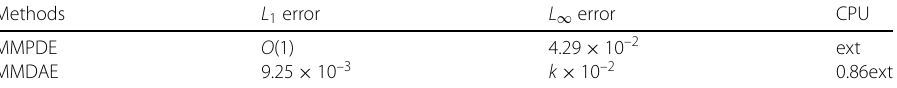
Table 1 Computation of L 1 and L ∞ errors using MMPDE and MMDAE methods with ρ = 10 4 , α = 1.5, β = 0.1, a = 1.015, τ = 10 –7 , N = 50, at time t = 2.5 × 10